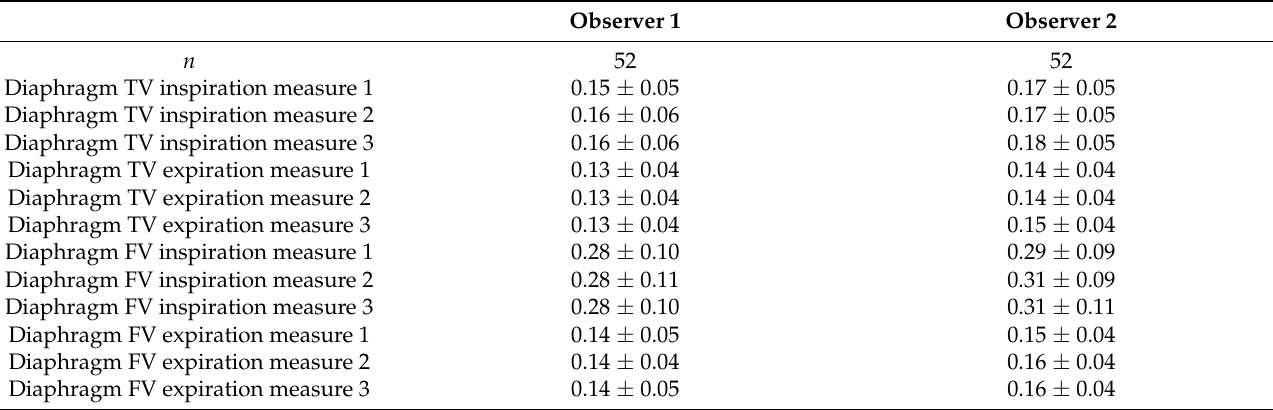
Table 3. Measures of the diaphragm activity sampled by